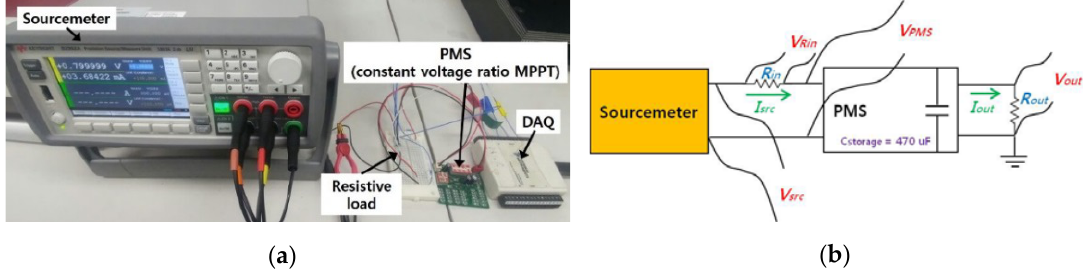
Figure 5. Experiments for evaluating the performance characteristics of PMS with different voltage ratios: ( a ) Experimental setup using the precision source meter as an energy source; ( b ) Circuit schematic showing the measured voltages.